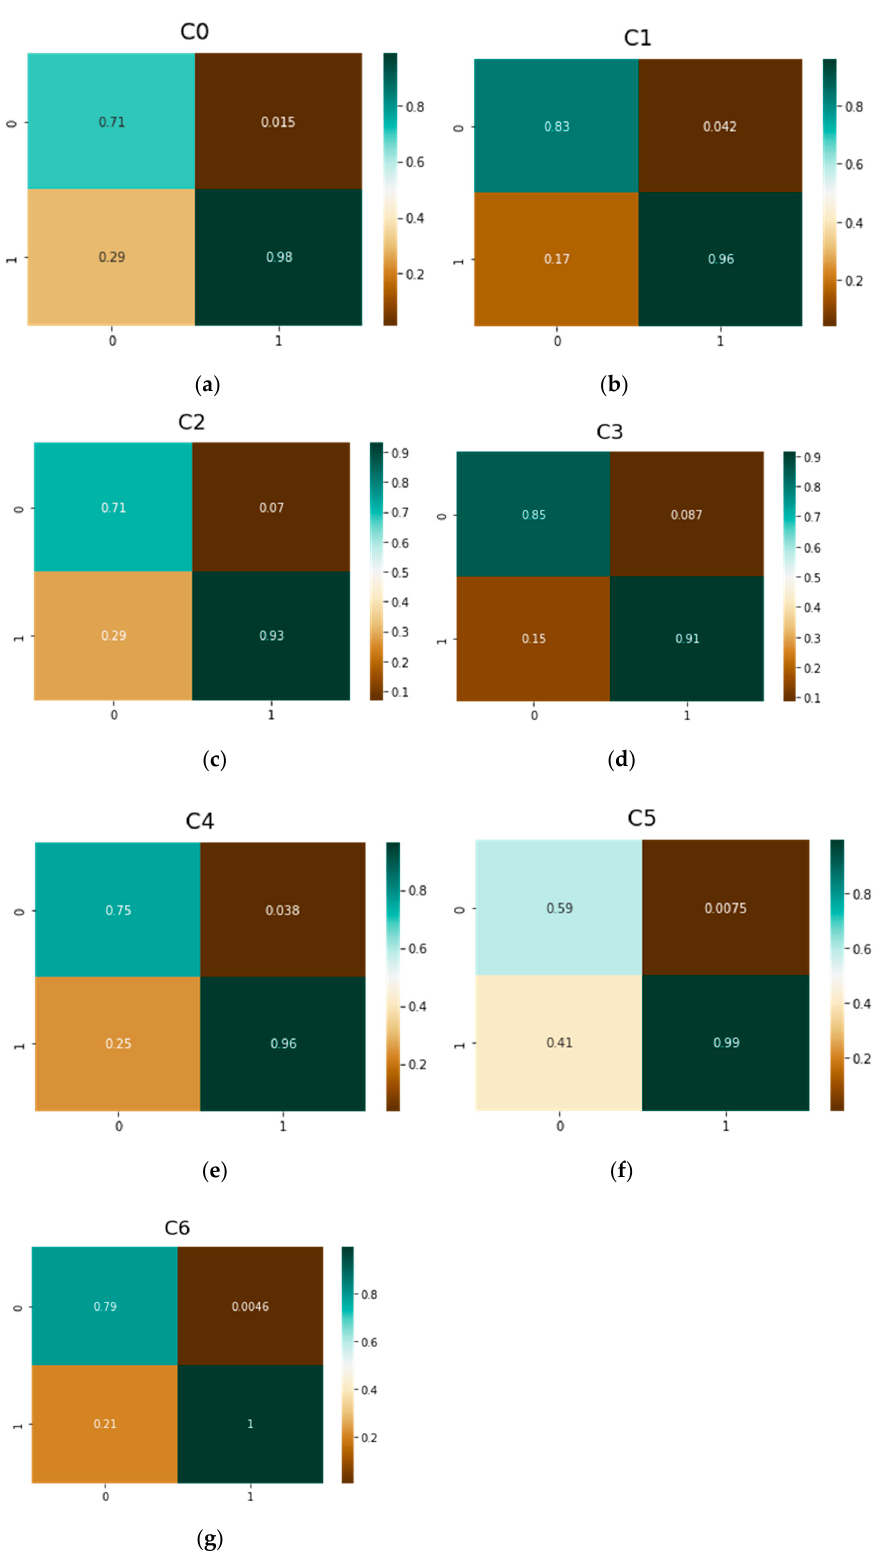
Figure 11. The multi-classification model based on vit-base-patch16-384. The confusion matrices